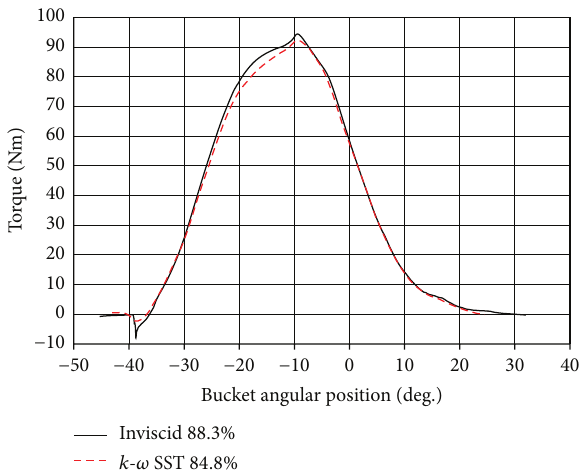
Figure 11: Comparison of inviscid and turbulent flow numerical